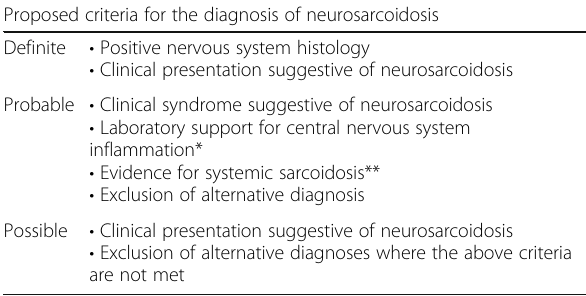
Table 3 Diagnostic criteria for neurosarcoidosis [34] Proposed criteria for the diagnosis of neurosarcoidosis Definite (cid:129) Positive nervous system histology (cid:129) Clinical presentation suggestive of neurosarcoidosis Probable (cid:129) Clinical syndrome suggestive of neurosarcoidosis (cid:129) Laboratory support for central nervous system inflammation* (cid:129) Evidence for systemic sarcoidosis** (cid:129) Exclusion of alternative diagnosis Possible (cid:129) Clinical presentation suggestive of neurosarcoidosis (cid:129) Exclusion of alternative diagnoses where the above criteria are not